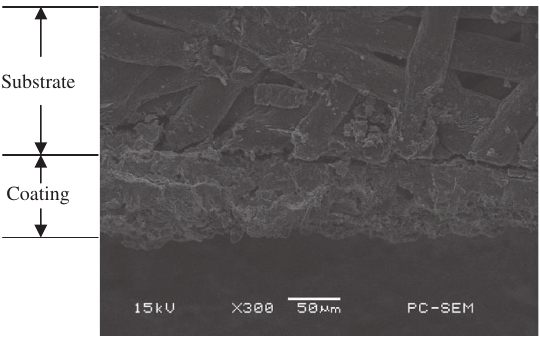
Figure 3 Scanning electron micrograph of the HA coating